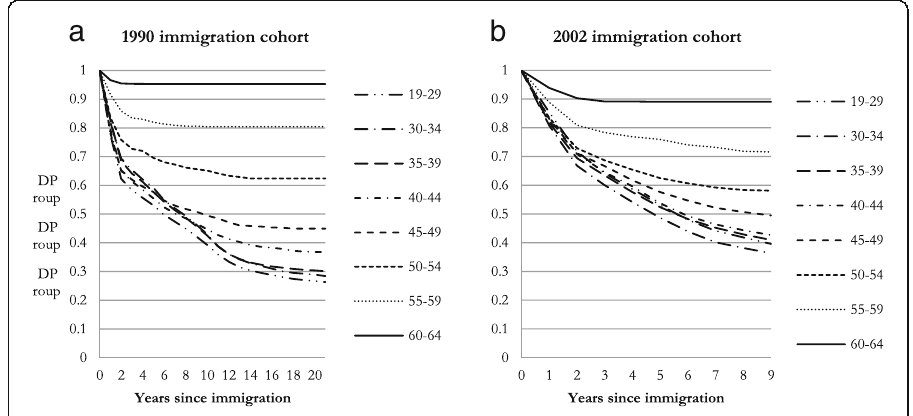
Fig. 6 a – b Life table survival estimates for time until annual income >2 PBB by